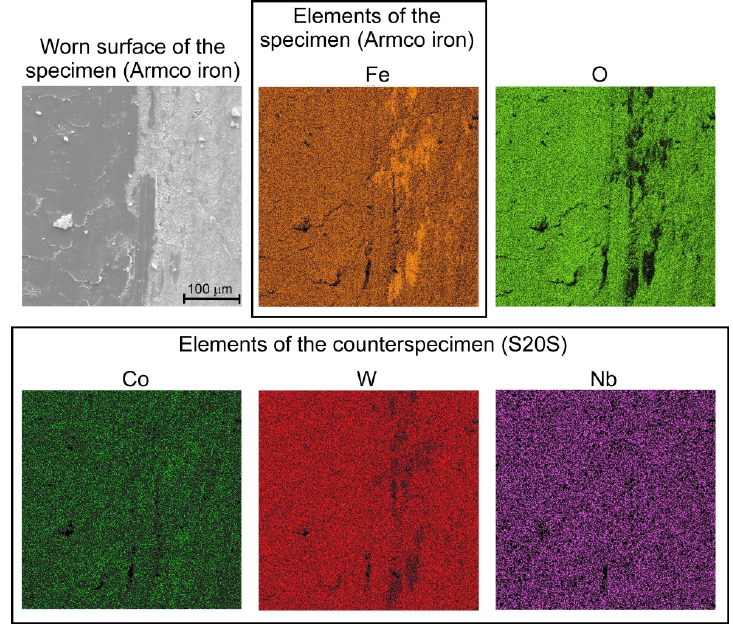
Figure 8. The worn surface and EDS patterns of untreated Armco iron.